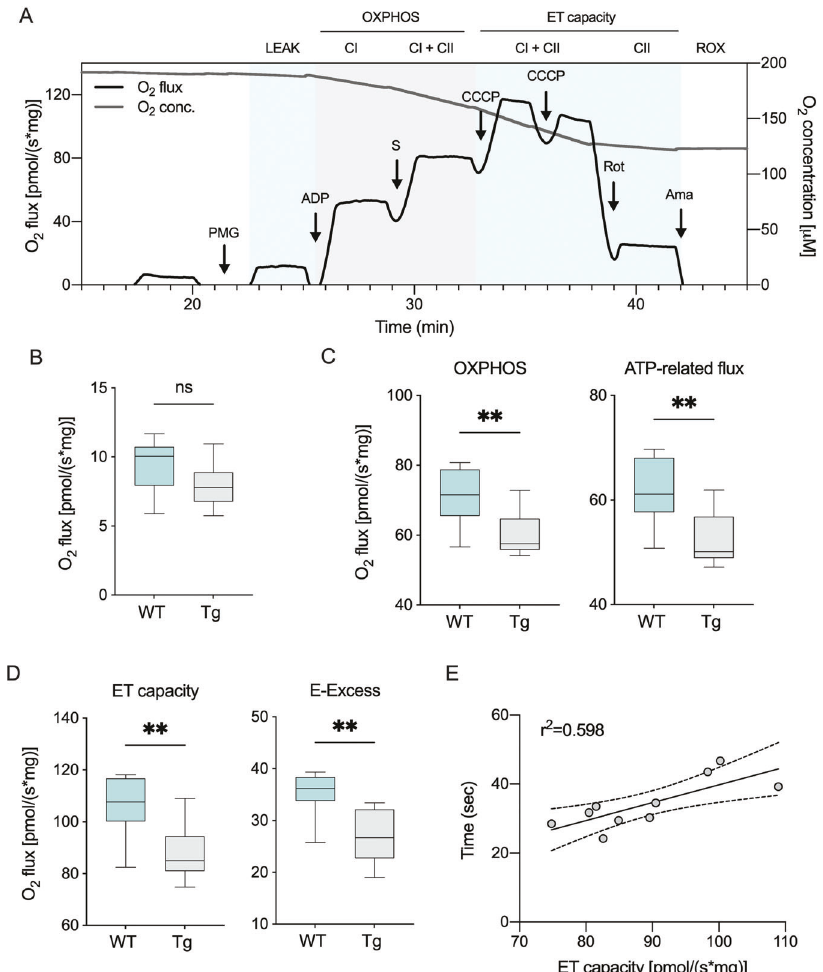
Fig. 2 Mitochondrial respiration is impaired in transgenic mice. A Representative trace of oxygen consumption achieved using homogenates from fresh spinal cords from wild type mice, and the SUIT protocol applied. Precisely, the LEAK state was measured in the presence of pyruvate, malate and glutamate (PMG) but not adenylates. The addition of ADP, followed by succinate (S), activated OXPHOS respiration sustained by complex I or complex I and II, respectively. The maximal capacity of ET chain was achieved by CCCP titration. The ET capacity sustained exclusively by complex II was measured after inhibition of complex I with rotenone (Rot). Finally, the ROX was measured after a complete inhibition of ET chain with antimycin A (Ama). B – D Comparative analysis of oxygen consumption in wild type and transgenic mice spinal cords ’ homogenates relative to LEAK B , OXPHOS, total and ATP-linked fl ow C , maximal ET capacity and E-Excess D . Data are expressed as pmol/s of oxygen per mg of tissue and as means ± SEM of n = 10 independent measurements. Data were statistically analyzed by Student t-test, with ** p < 0.01; ns not signi fi cant. E Correlation analysis of ET capacity with the loss of motor activities calculated as linear regression ( r 2 = 0.598, p = 0.0087). The dotted lines represent 95% con fi dence